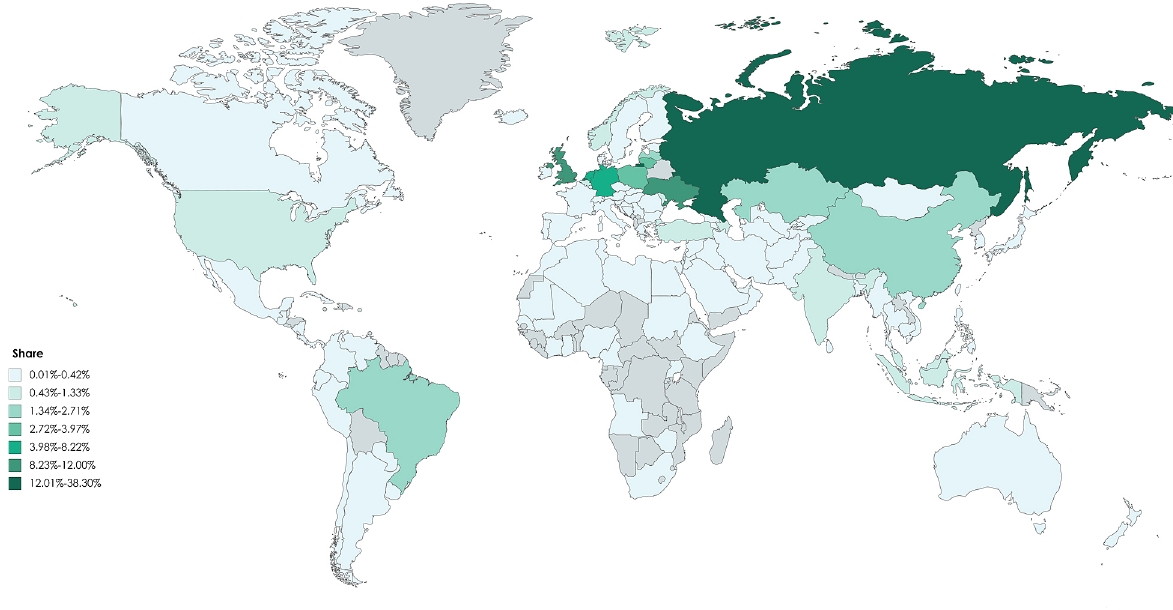
Fig. 1. Geographical structure of goods exports of the Republic of Belarus (2018). Source: own study based on the National Statistical Committee of the Republic of Belarus (2019).